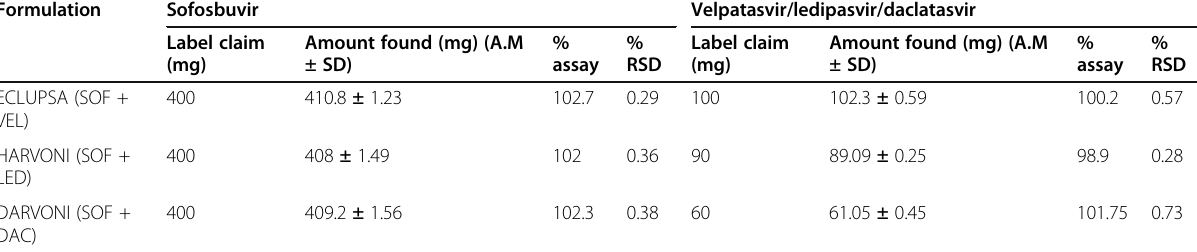
Table 8 Assay of the marketed formulations Formulation